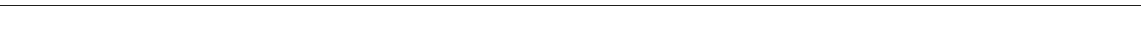
Fig. 4 Lsd1 represses brown adipogenesis in satellite cells. a – d Analyses of FACS sorted Ctrl, Lsd1 iKO , and Lsd1(i)-treated satellite cells differentiated for 7 days in adipogenic medium. a Oil red O (ORO) staining (1) and immuno fl uorescence assays using antibodies directed against: Lsd1 (green) and Myh (red) (2), Ucp1 (green) and Myh (red), (3) or GFP (green) and Myh (red) (4). ORO fl uorescence is depicted in white. Nuclei were stained with DAPI (blue). Arrows indicate that ORO-positive adipocytes express Ucp1 (3) and nGFP (4). b – d Signi fi cance was calculated by two-way ANOVA test. b Quanti fi cation of ORO-positive adipocytes that originate from nGFP-expressing satellite cells per cm 2 . c Measurement of ORO fl uorescence intensity in nGFP-positive satellite cells displayed as percentage of Ctrl. d qRT-PCR analysis showing relative transcript levels of indicated genes. e – h Analyses of FACS sorted control (Ctrl-mCh) and LSD1 overexpressing (LSD1-mCh) satellite cells differentiated for 7 days in adipogenic medium. e ORO staining (1) and immuno fl uorescence assays using antibodies directed against: GFP (green), mCherry (mCh) (red), and Myh (white) (2), Ucp1 (green), mCh (red), and ORO (white) (3), or GFP (green), mCh (red), and ORO (white) (4). Nuclei were stained with DAPI (blue). Arrows indicate that ORO-positive adipocytes express Ucp1 (3) and nGFP (4). f – h Signi fi cance was calculated by two-tailed Student ’ s t -test. f Quanti fi cation of ORO-positive adipocytes that originate from nGFP-expressing satellite cells per cm 2 . g Measurement of ORO fl uorescence intensity in nGFP-positive satellite cells displayed as percentage of Ctrl- mCh. h qRT-PCR analysis showing relative transcript levels of indicated genes. ( b , c , f , g : n = 6, d , h : n = 4; mean + SEM, * p < 0.05, ** p < 0.01, *** p < 0.001; scale bars: a and e : (1) 50 µ m; (2 – 4) 100 µ m)